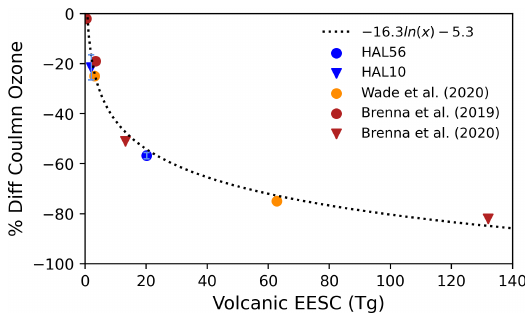
Figure 11. Relationship between volcanically emitted equivalent effective stratospheric chlorine (Tg) and peak global-mean % dif- ference in column ozone. Blue: HAL10 and HAL56 ensemble mean and range. Orange: Wade et al. (2020) ensemble mean. Red: Brenna et al. (2019, 2020) ensemble